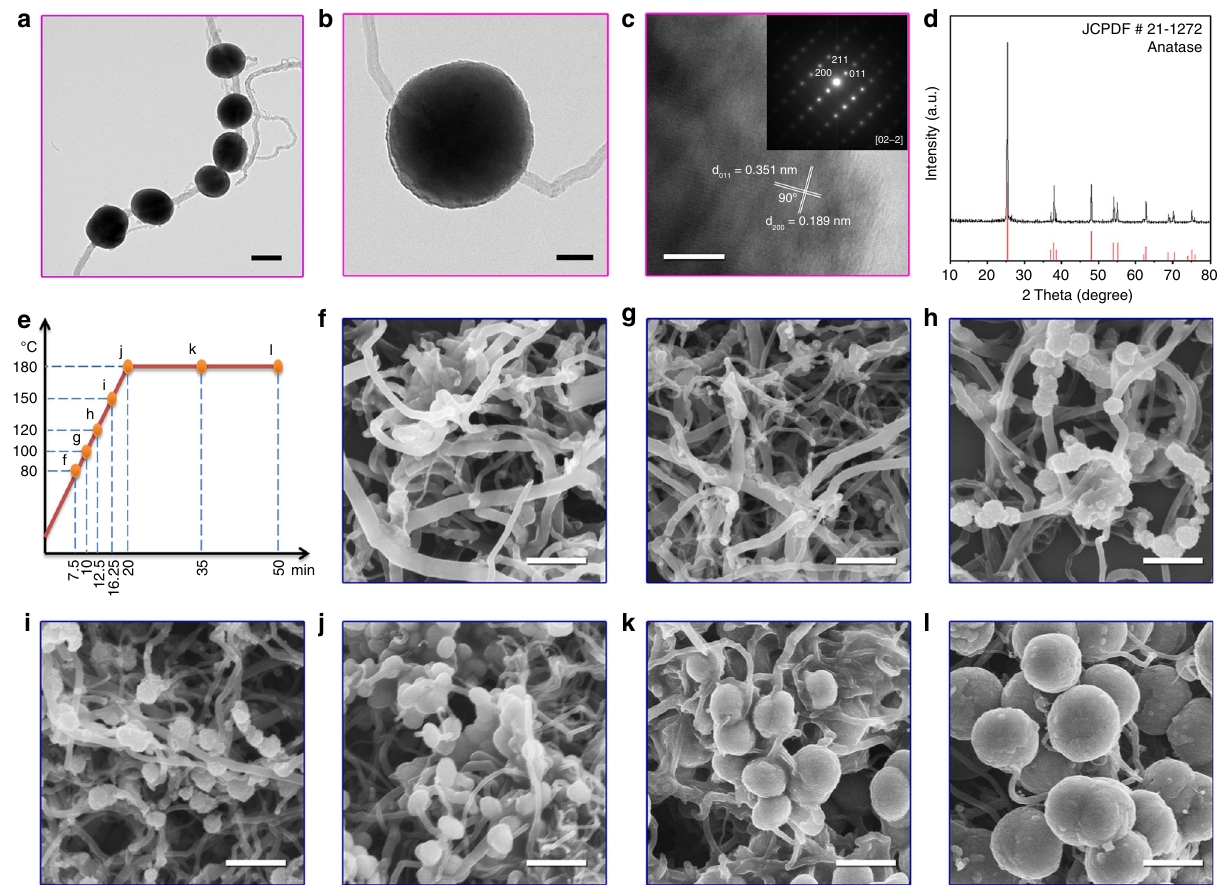
Fig. 2 Morphology and phase structure of chloroplast structured CNT-TiO 2 . TEM images ( a , b ), HRTEM image with attached SAED pattern ( c ), and XRD pattern ( d ) of the as-prepared CNT-TiO 2 . Different CNT-TiO 2 samples prepared at desired microwave-heating time and temperature ( e ) and their corresponding FESEM images ( f – l ). Scale bars in ( a ): 500 nm, ( b ): 100 nm, ( c ): 2 nm, and ( f – l ): 500